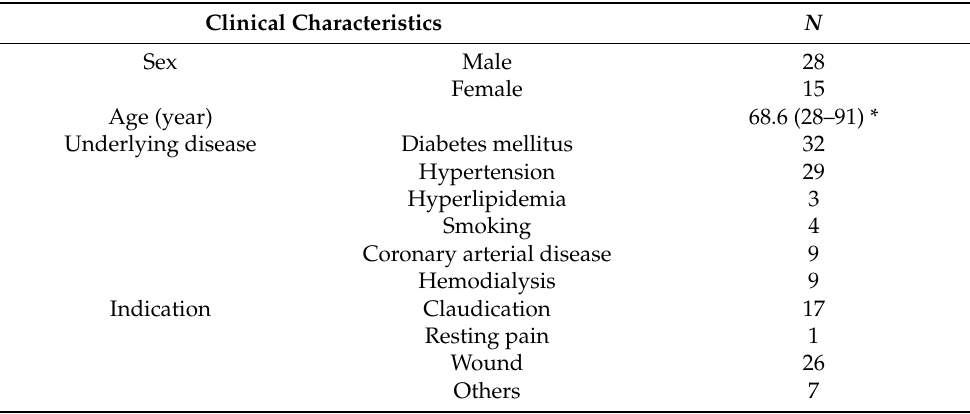
Table 1. Basic characteristics of 43